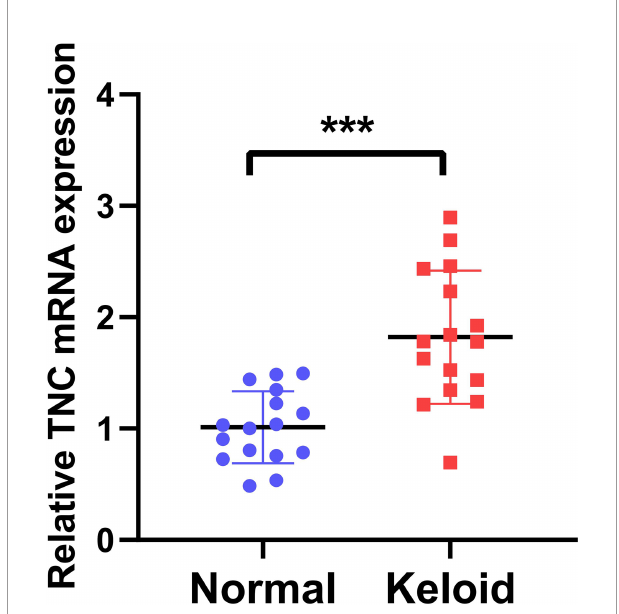
FIGURE 10 | Quantitative Real-Time Polymerase Chain Reaction (qRT-PCR). The TNC expression in keloid was signi fi cantly higher than the Peri-keloid normal tissue from the same patient.